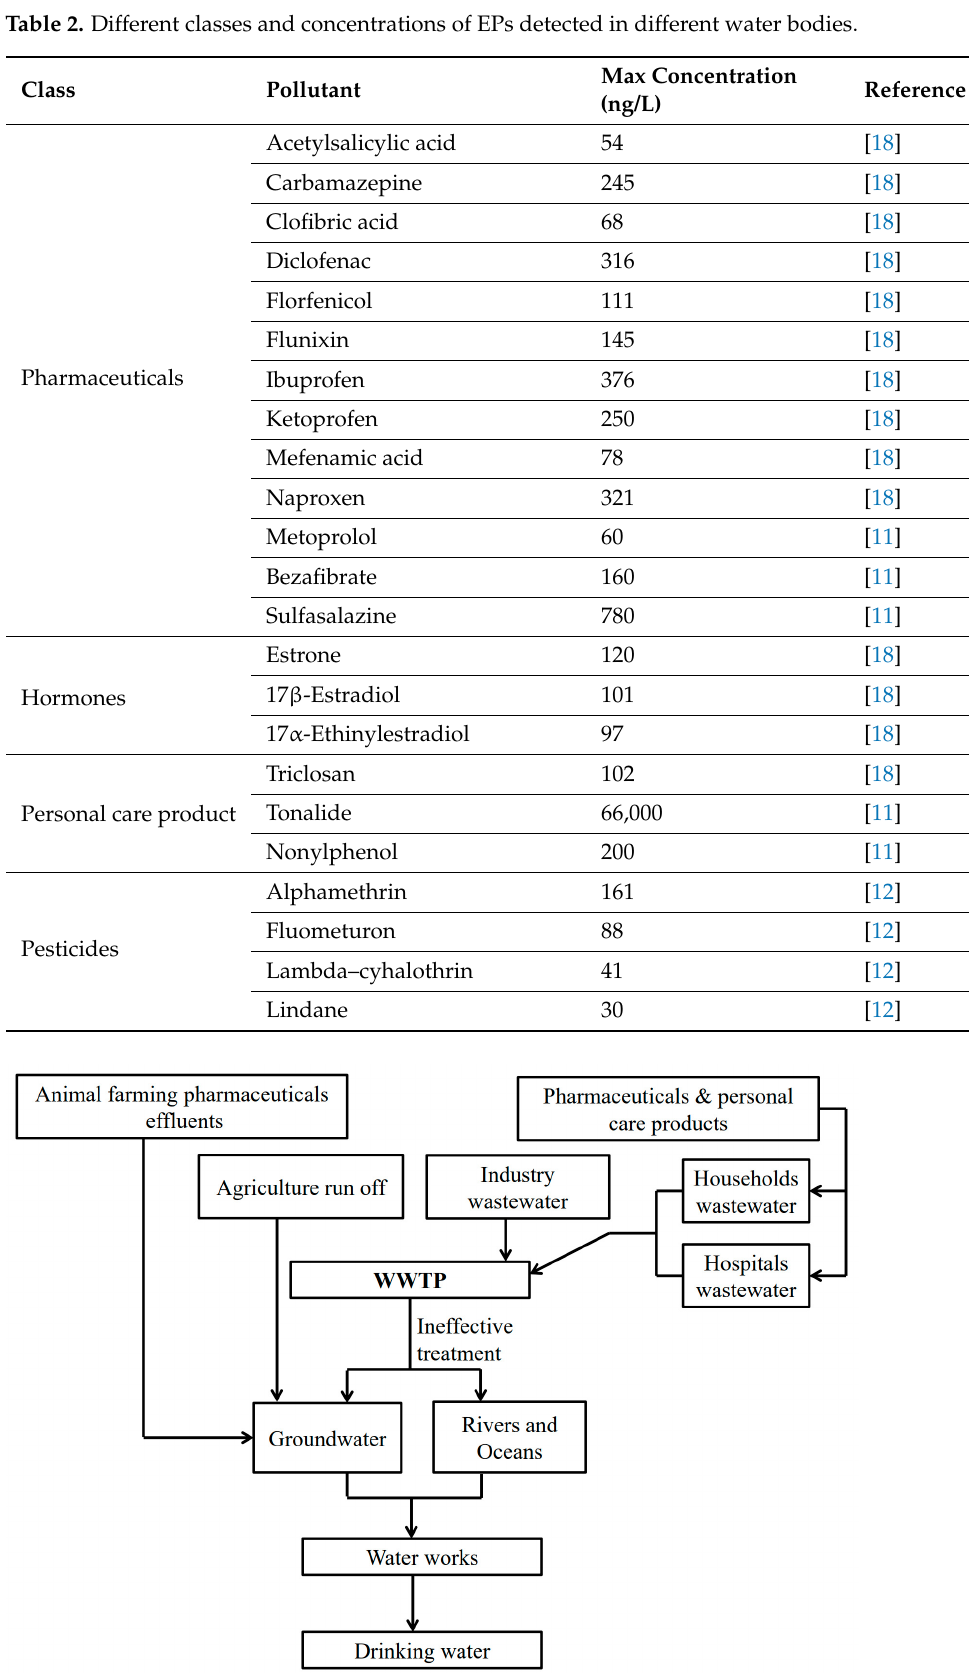
Figure 1. Potential pathways for emerging pollutants (Eps) to enter drinking